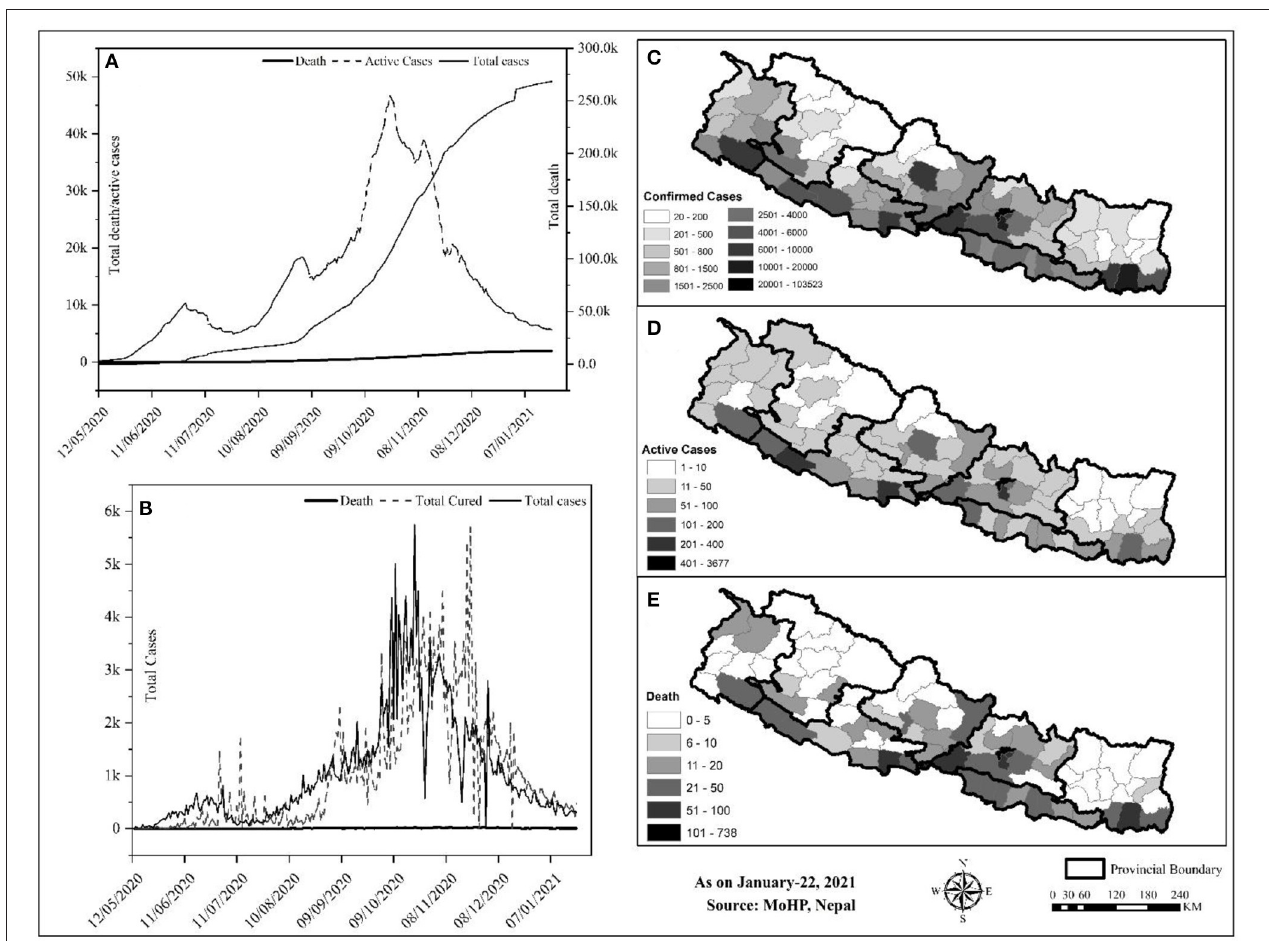
FIGURE 3 | Trend and spatial distribution of COVID-19 cases in Nepal. (A) Cumulative trend analysis of COVID-19 cases, (B) daily case wise trend analysis of COVID-19, (C–E) spatial distribution of infected, recovered, and death cases.